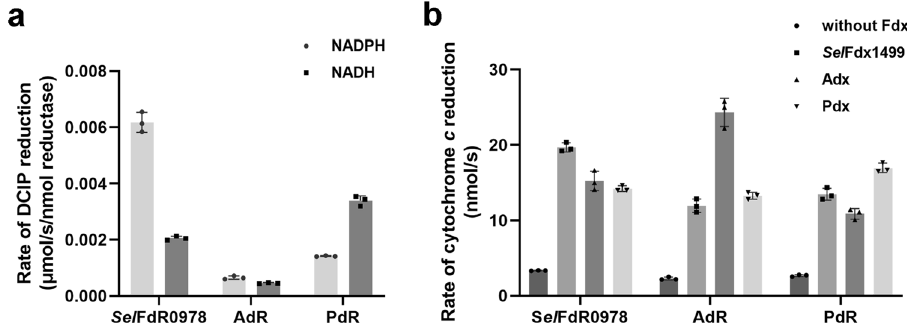
Fig. 3 DCIP and cyt c reduction assays. a DCIP reduction activities of the three redoxin reductases in the presence of 1 mM NADH or NADPH. b Rates of electron transfer measured by cyt c reduction. The reaction mixture contained 30 μ M cyt c , 10 nM FdR or 10 nM FdR coupled with 20 nM Fdx, and started by adding 500 μ M NAD(P)H. All experiments were independently repeated for three times. The error line represents the standard deviation. P values in each groups were calculated with single factor ANOVA analysis, and all P values were